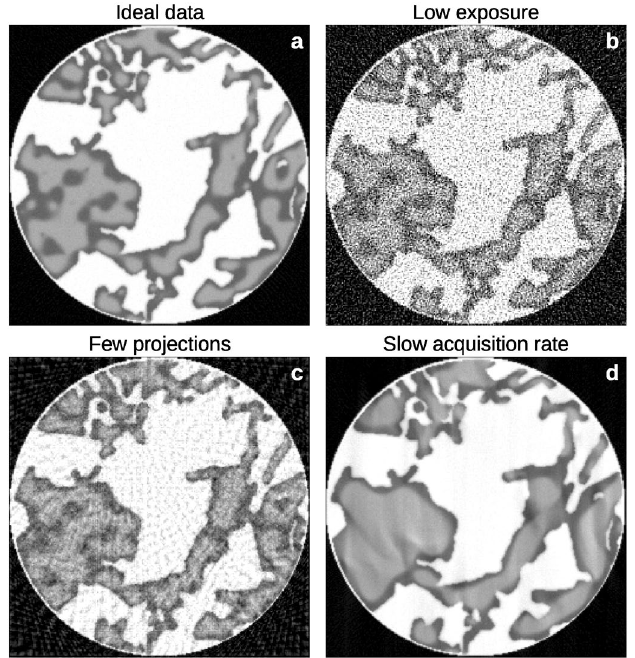
Figure 1. The reconstructions resulting from a tomographic experiment is highly affected by the experimental parameters. To visualise the potential effects that might occur in dynamic tomography, we have performed reconstructions of three data sets that are each limited in one experimental parameter. ( a ) The “ideal” reconstruction of the system, which is carbonate rock (white) filled with a fluid mixture of oil (dark grey) and water (light grey). ( b ) A reconstruction performed on data limited in the signal-to-noise ratio, i.e. short exposure or low X-ray brilliance. ( c ) A reconstruction from a data set with a low number of projections. ( d ) A reconstruction performed on data with high signal-to-noise (long exposure) and high number of radiographs, i.e. long data collection leading to low temporal